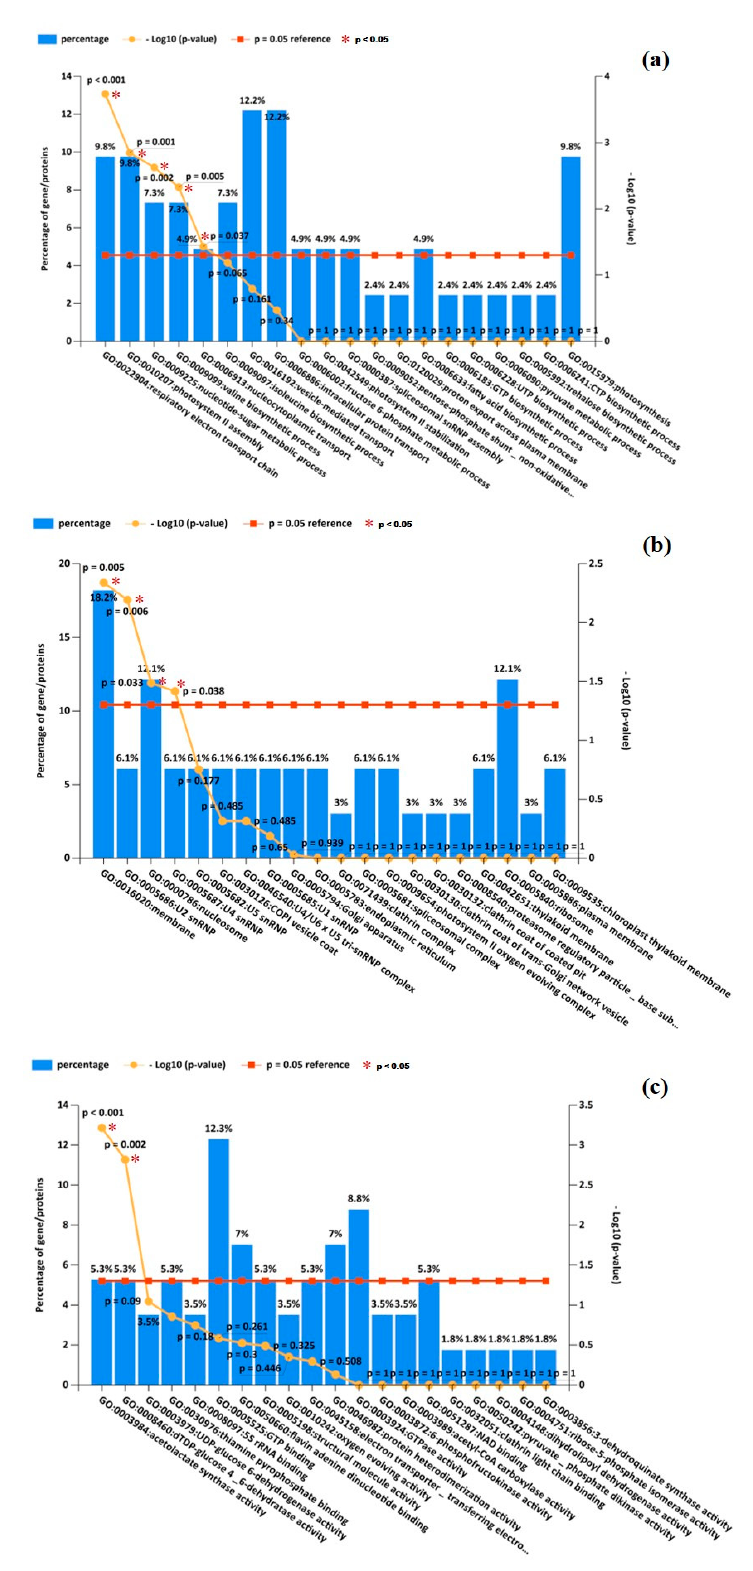
Figure 3. Top 20 gene ontology (GO) annotations of ( a ) biological process, ( b ) cellular component, and ( c ) molecular function cluster between Exp. and Con. The comparison arranged according to decreasing − log10 ( p -value) (yellow line). Percentages of GO annotations belonging to each process are shown blue bars, − log10 ( p = 0.05) is shown as a reference (red line). * = p < 0.05.